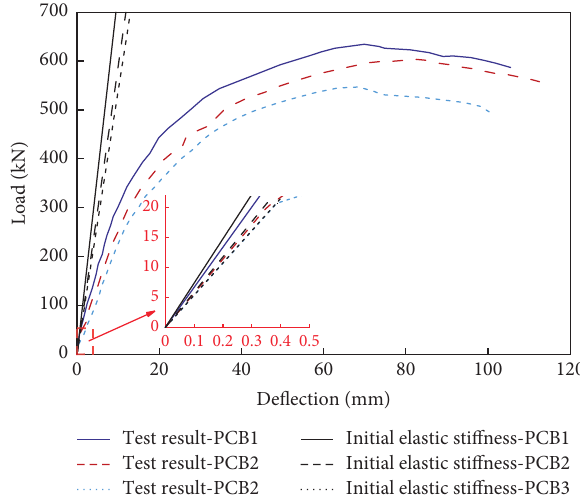
Figure 15: Comparisons between the FE results and experimental results.